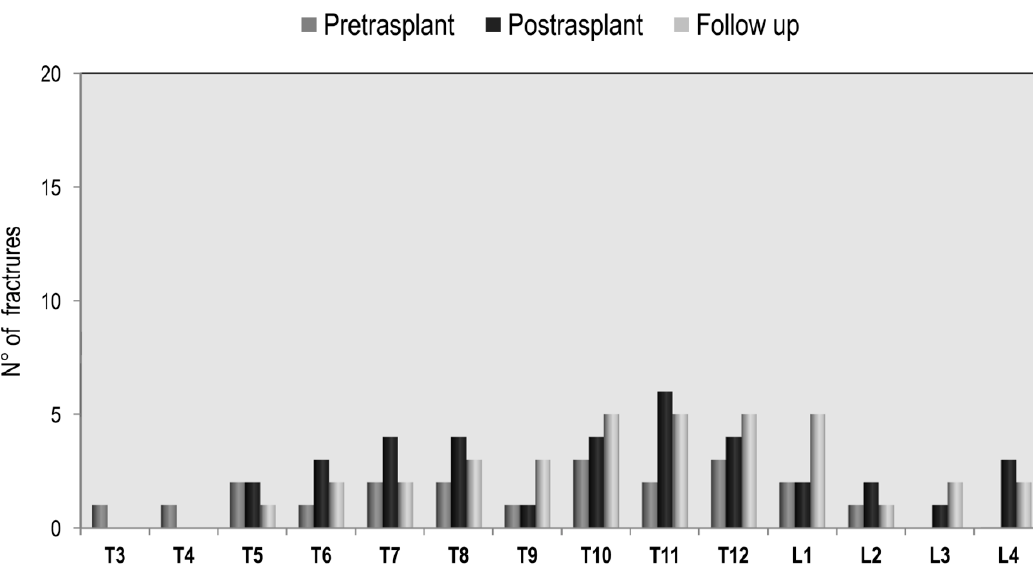
Figure 5. Distribution of vertebral fractures in heart transplantation.